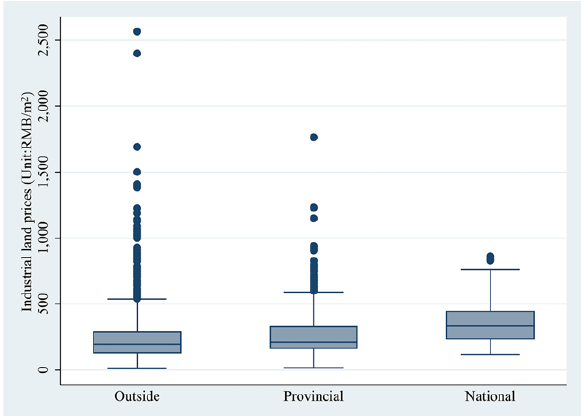
Figure 10. Comparisons of industrial firms in national and provincial development zones and other areas